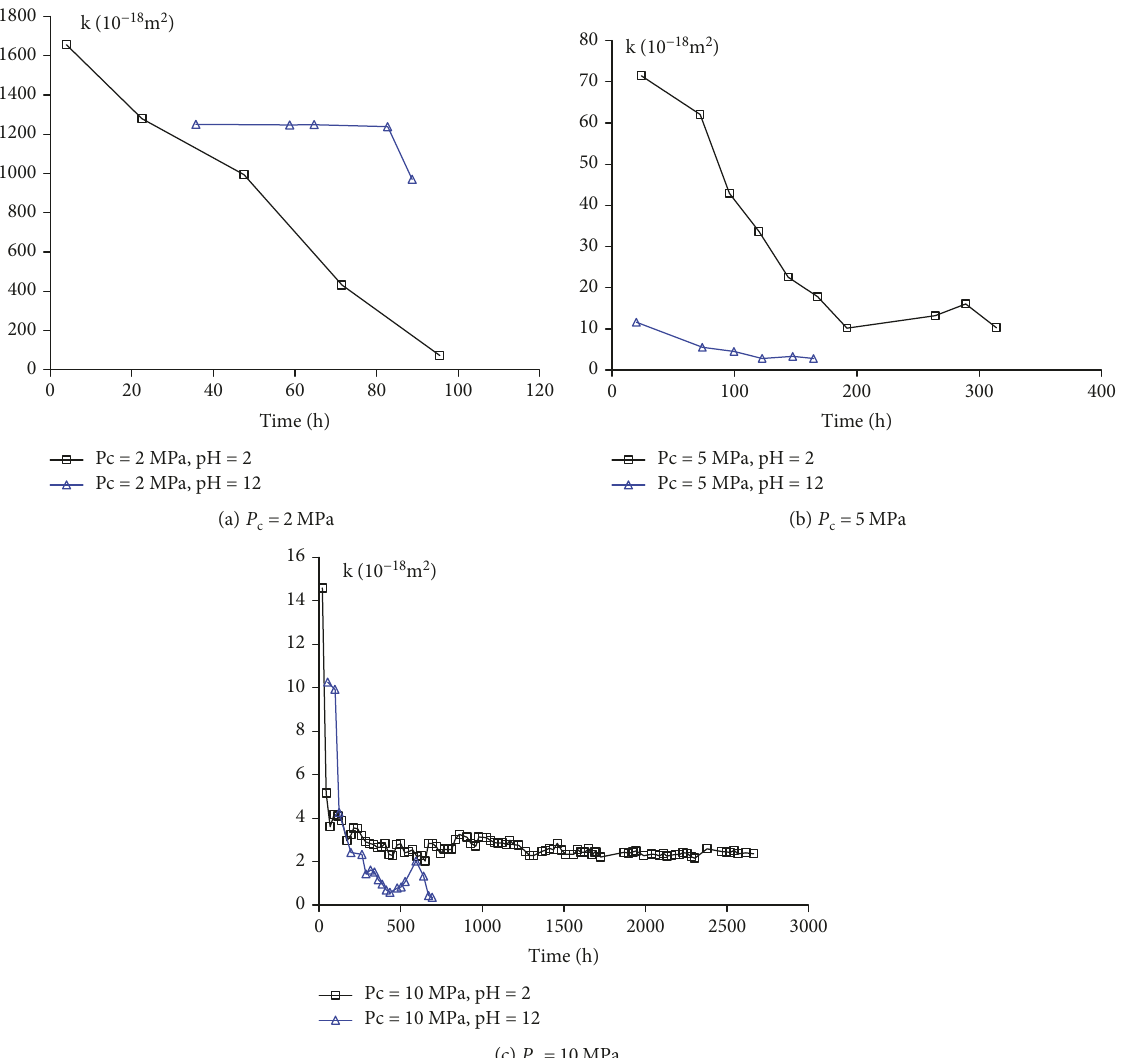
Figure 7: Permeability evolutions of the cracked samples under di ff erent con fi ning pressures and reactive solution